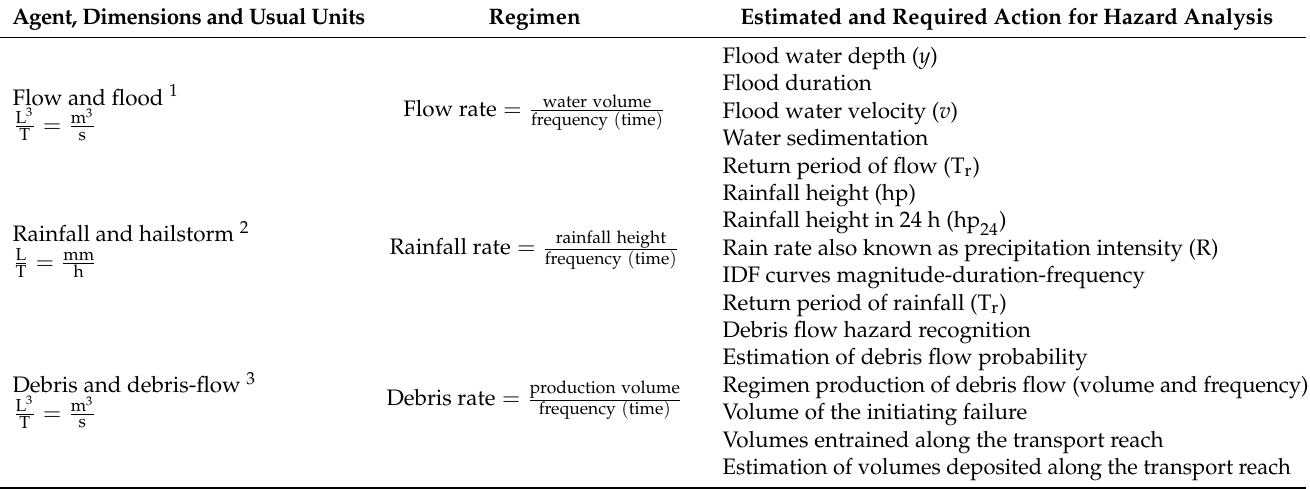
Table 4. Risk and hazard analysis of the principal agents involved in Forensic